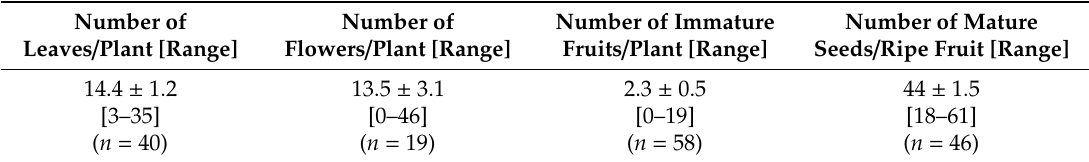
Table 1. Growth productivity attributes of wild Mandragora autumnalis Bertol. plants visited in six natural locations (means ± SE).